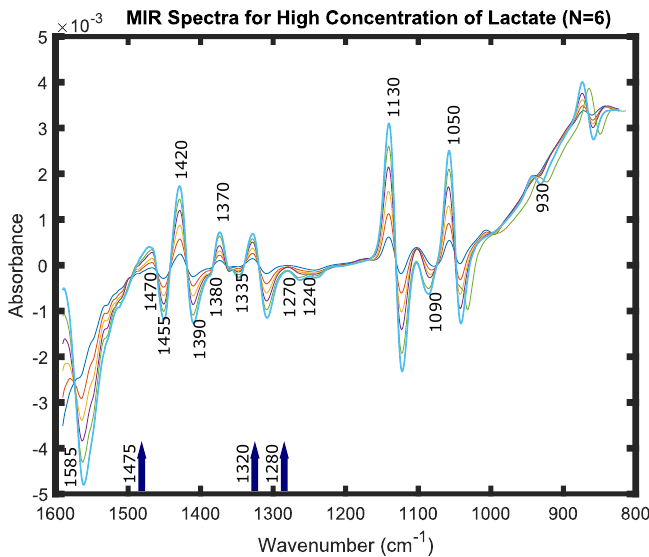
Figure 1. Peaks of interest in the MIR spectral region 800–1600 cm − 1 , pertinent to high lactate concentration changes. The set of six spectra of very high concentration of lactate in PBS (100 (dark green), 200 (orange), 300 (yellow), 400 (red), 500 (light green) and 600 mM (blue)) were obtained by ATR-FTIR spectroscopy and pre-processing was performed. The pre-processing included: spectral subtraction of 0 mM lactate spectra, EMSC (quadratic polynomial) and Savitzky-Golay filtering (Polynomial Order = 2, Derivative = 2 and Window Length = 101). The peaks 860 cm − 1 , 930 cm − 1 , 1050 cm − 1 , 1090 cm − 1 , 1130 cm − 1 , 1240 cm − 1 , 1270 cm − 1 , 1280 cm − 1 , 1320 cm − 1 , 1335 cm − 1 , 1370 cm − 1